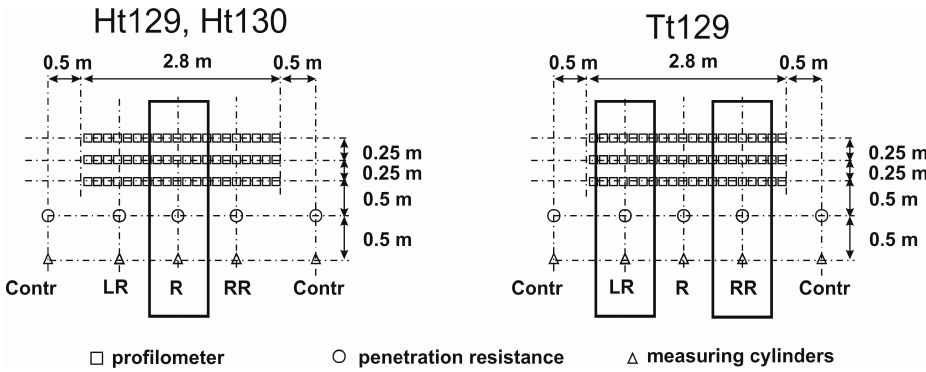
Figure 1. Photographs of the sections of skid trails selected for the study: ( a ) Ht129U, ( b ) Ht129L, ( c ) Ht130U, ( d ) Ht130L, ( e ) Tt129U, and ( f ) Tt129L.